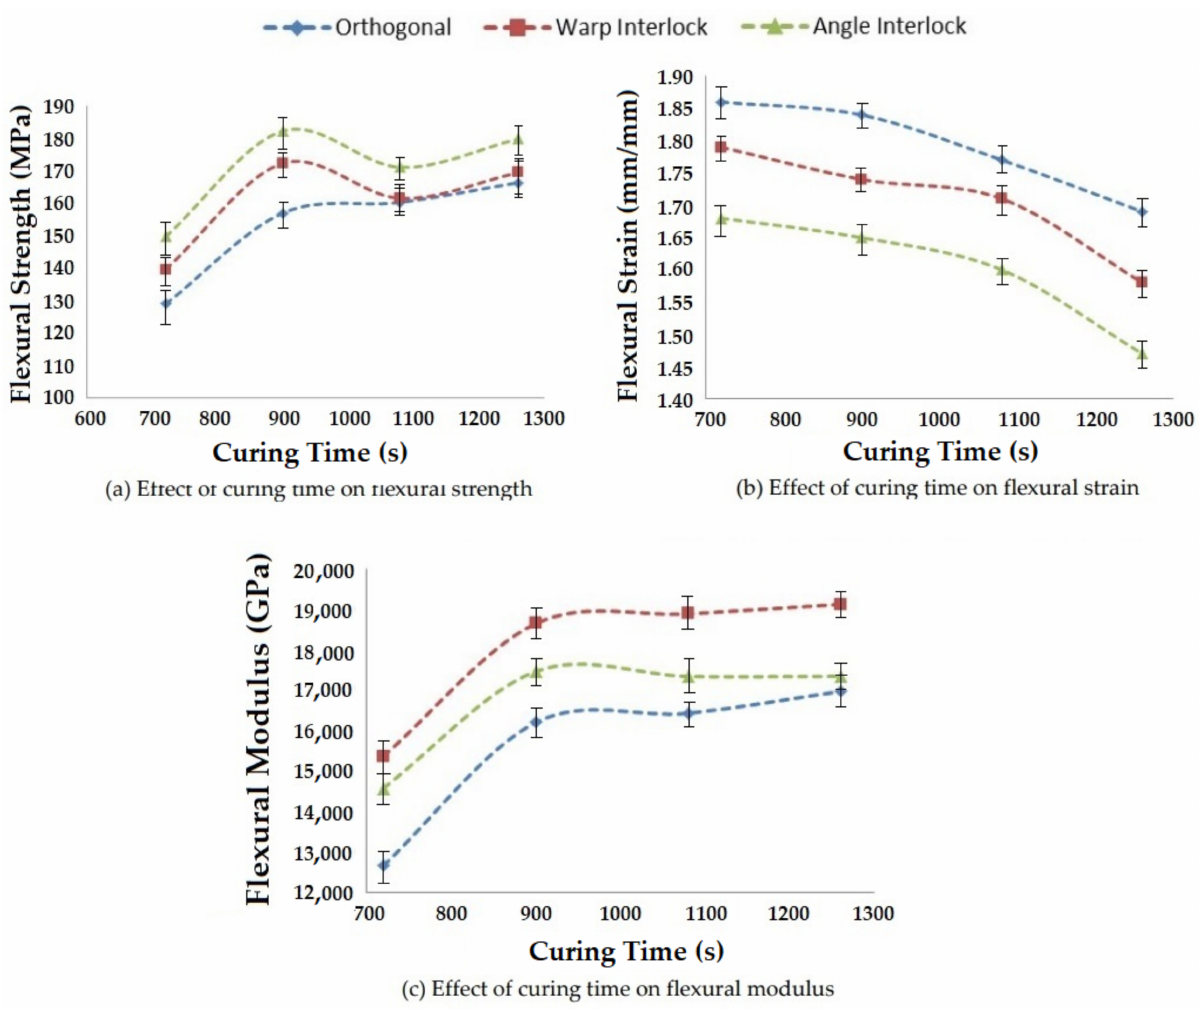
Figure 21. Effect of curing time on the flexural properties of 3D woven